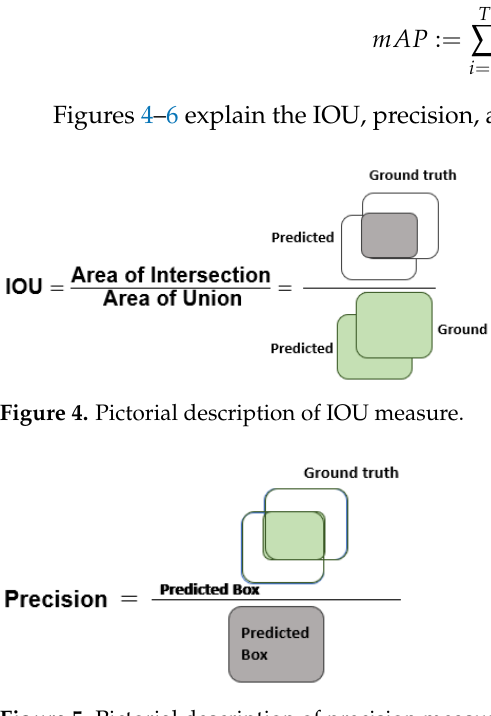
Figure 5. Pictorial description of precision measure .